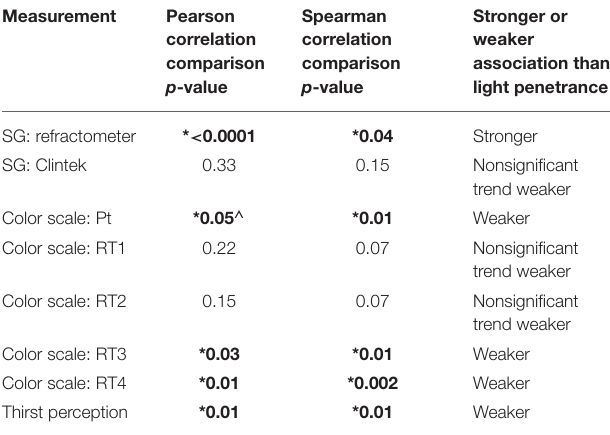
TABLE 2 | Strength of correlation between light penetrance and osmolality compared to correlation between other hydration markers and urine osmolality. Measurement Pearson Spearman correlation correlation comparison comparison p -value p -value